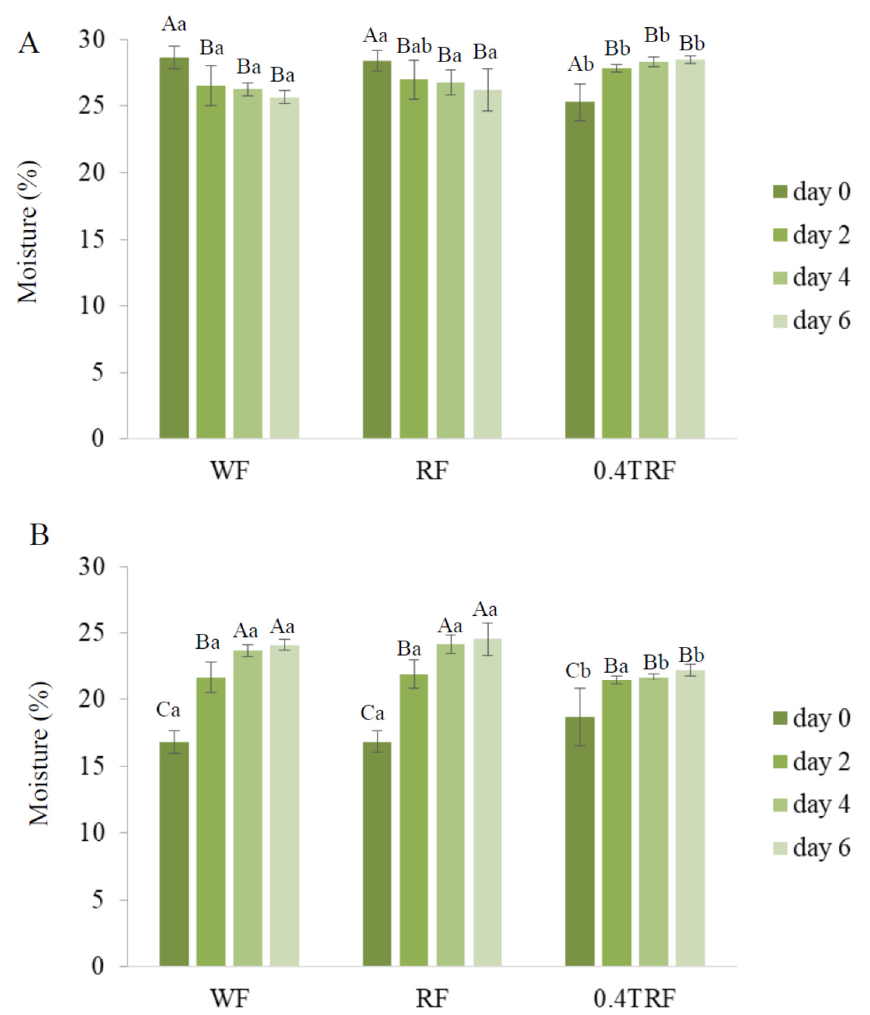
Figure 5. Moisture content change of cake and gluten-free cake: crumb ( A ) and crust ( B ). a-b Di ff erent letters indicate significant di ff erence between di ff erent samples (n = 3; p < 0.05). A-C Di ff erent letters indicate significant di ff erence between di ff erent days (n = 3; p < 0.05). WF: cake made with 100% wheat flour; RF: gluten-free cake supplemented with 100% rice flour; 0.4TRF: gluten-free cake with 0.4% tamarind seed gum addition.